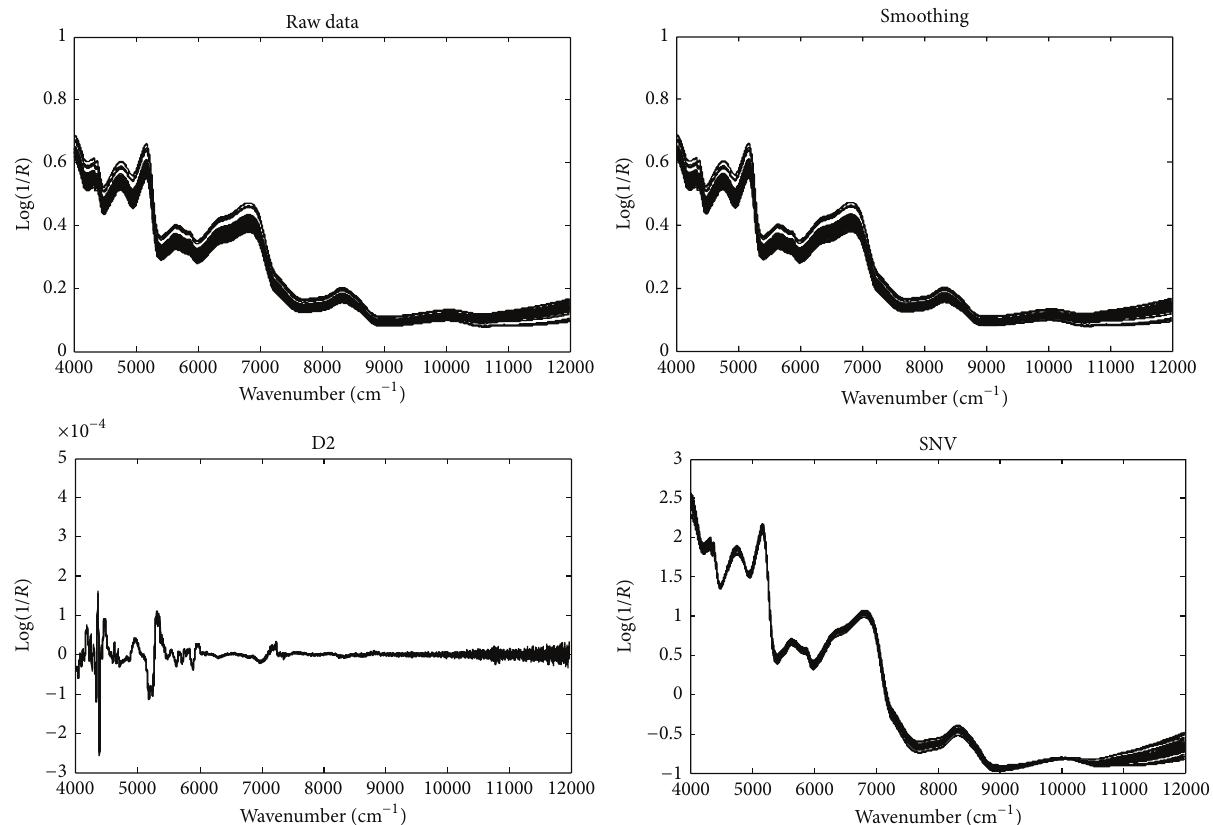
Figure 1: The raw NIR spectra and the smoothed, second-order derivative (D2), and standard normal variate (SNV) spectra of brown rice